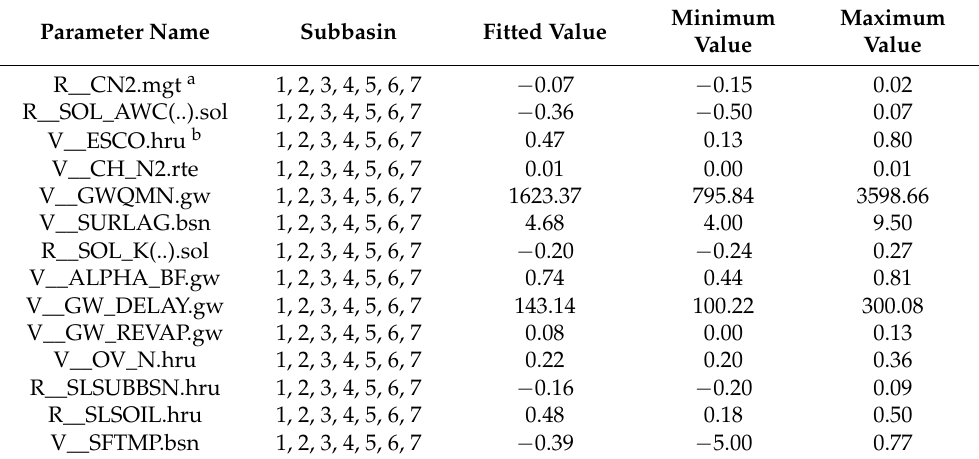
Table 1. Parameters used in streamflow auto-calibration for Merigold station using SUFI-2.